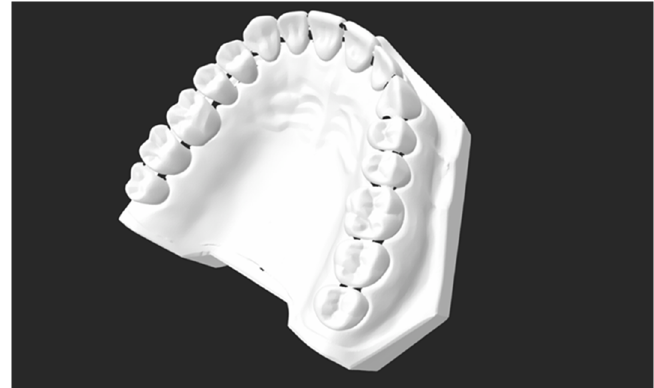
Figure 1. Three-dimensional mesh of the reference model.